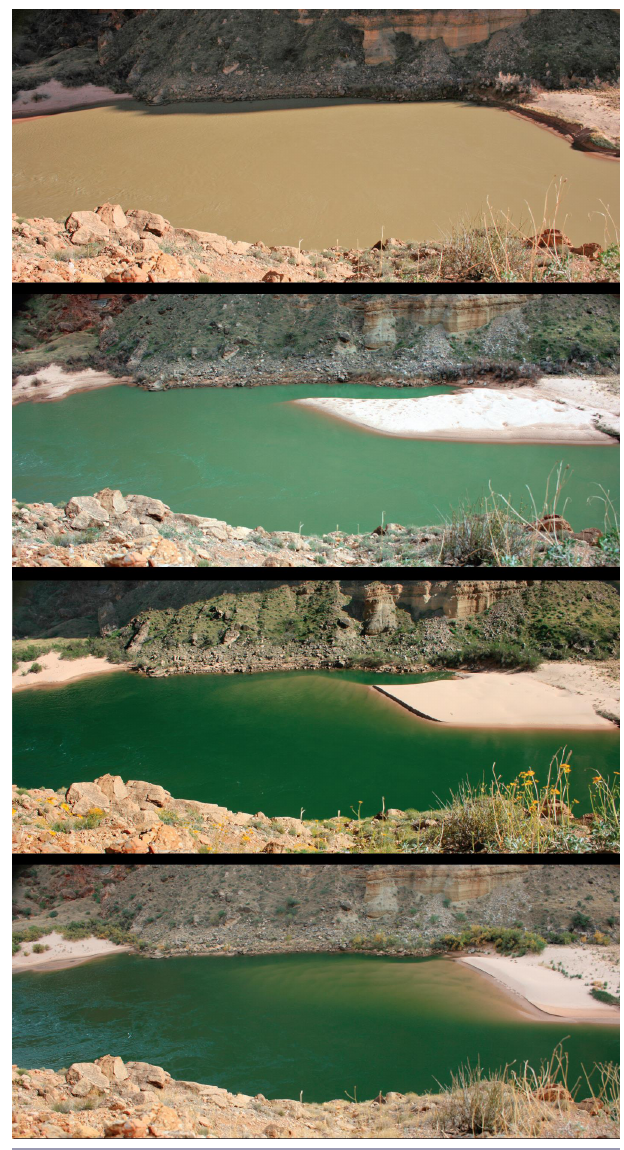
Fig. 2 . Matched photographs taken by a remote camera from the right bank of a river-left sandbar on the Colorado River about 96 km downstream from the dam. The series of photographs shows how the sandbar and its accompanying backwater (the area of water behind the sandbar used by both native and non-native fishes) were affected by the March 2008 high flow experiment and subsequent erosion in the 8 months following the high flow experiment. All of the photographs were taken at about 4 p.m. at a water level associated with a flow rate of about 240 m 3 /s from Glen Canyon Dam. (Credit: